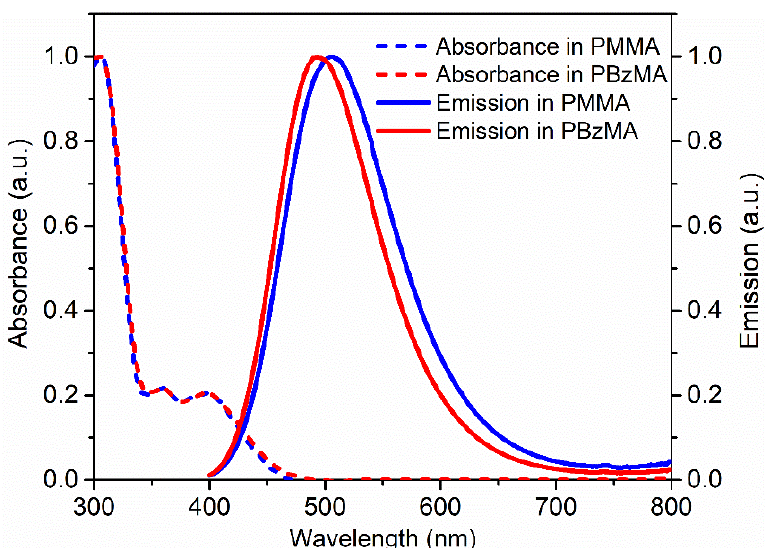
Figure 2. Normalized absorbance and emission spectra of DACT-II in PMMA and PBzMA.